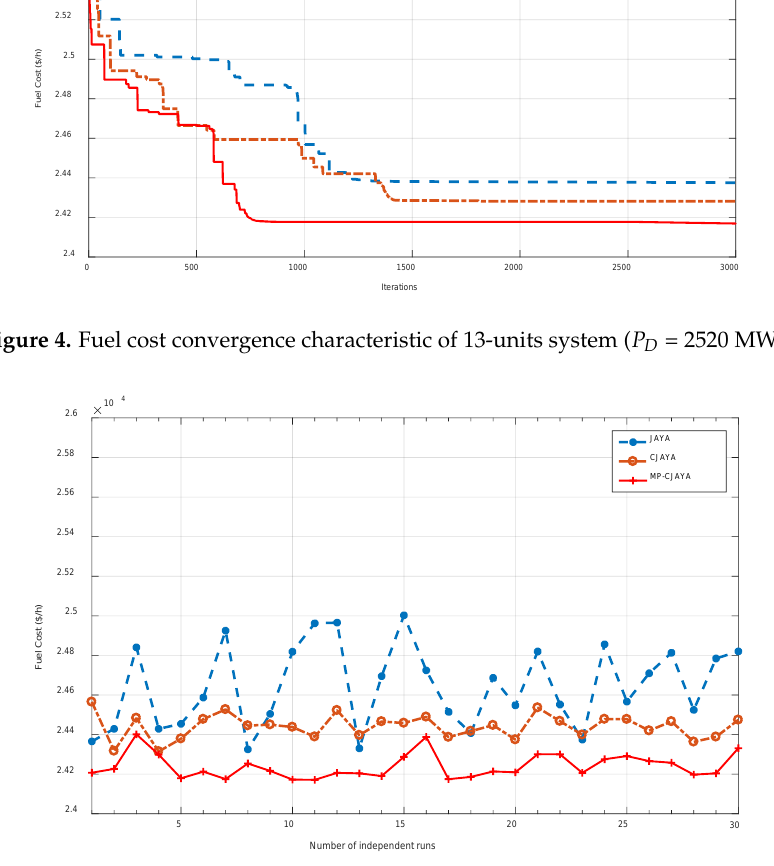
Figure 5. Fuel cost for 30 independent runs of 13-units system (